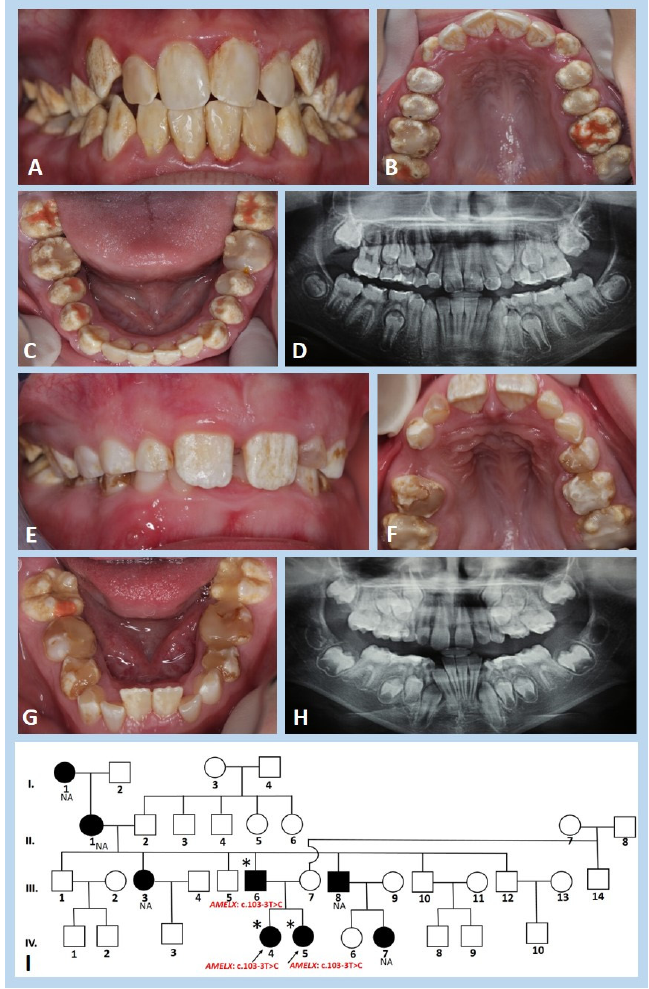
Figure 2. Clinical photographs, panoramic radiographs, and pedigree of the girls from family II. ( A – C ) Hypomineralised mixed dentition of the 11-year-and-6-month-old girl (IV.4) also exhibits some hypoplastic areas on all tooth crowns. Teeth are whitish with diffuse chalky-like patches, in some areas altering to yellow-brownish. All permanent incisors are restored with composite resins and all premolars and molars with glass ionomers. ( E – G ) The enamel of the 6-year-and-9-month-old sister (IV.5) is similarly altered, of chalky to yellowish colour. All deciduous and permanent molars are covered with extensive temporary fillings. ( D , H ) The panoramic radiographs show the enamel of adequate thickness, but with radiopacity, similar to dentine. ( I ) The filled symbols denote individuals of four generations of family II who have similarly affected enamel. Arrows indicate both girls examined (IV.4 and IV.5), the symbol (*) indicates family members who participated in the study, and NA indicates non-available family